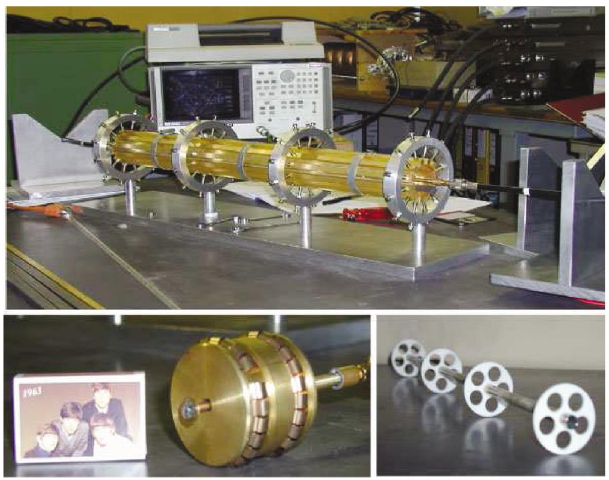
FIG. 9. (Color) Q -factor measurements setup. The upper image shows the pipe connected to a network analyzer to measure (in transmission) the Q factor of the TEM resonator obtained inserting a silver-plated steel tube along the axis of the pipe (lower right photo). The bar is kept in the center by proper (white) Teflon supports which are perforated to perturb the field as little as possible. The left lower photo shows one of the two identical coupling electrodes (next to a matches six steel bars (gray ones) alternatively, while in Fig. 9 all the 12 brass bars are placed.